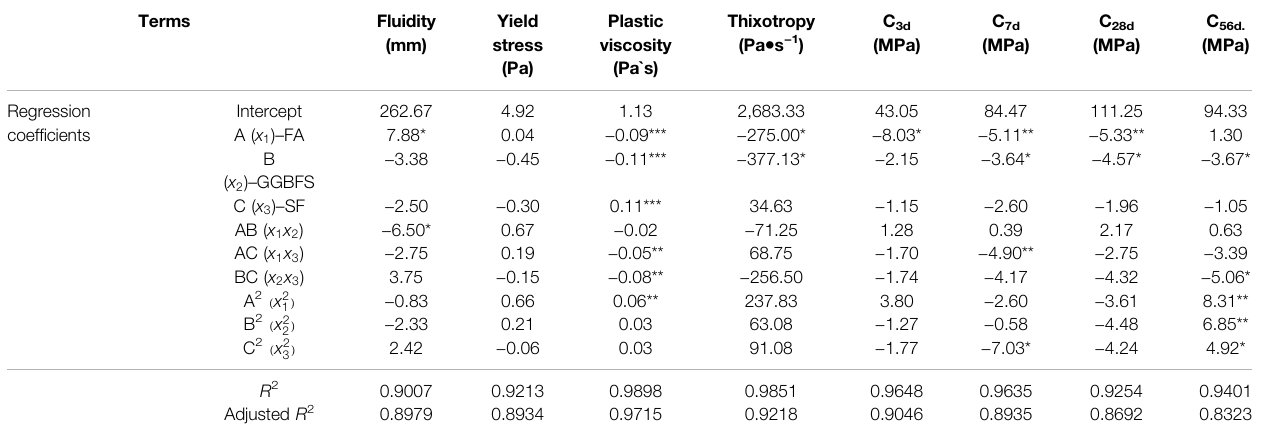
TABLE 5 | Results of ANOVA and regression coef fi